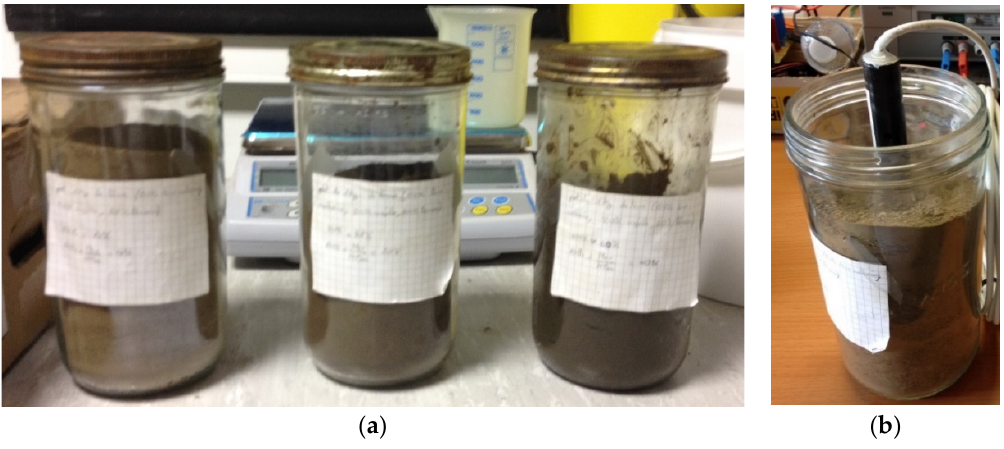
Figure 1. Calibrated samples in jars ( a ) and the measurements ( b ).